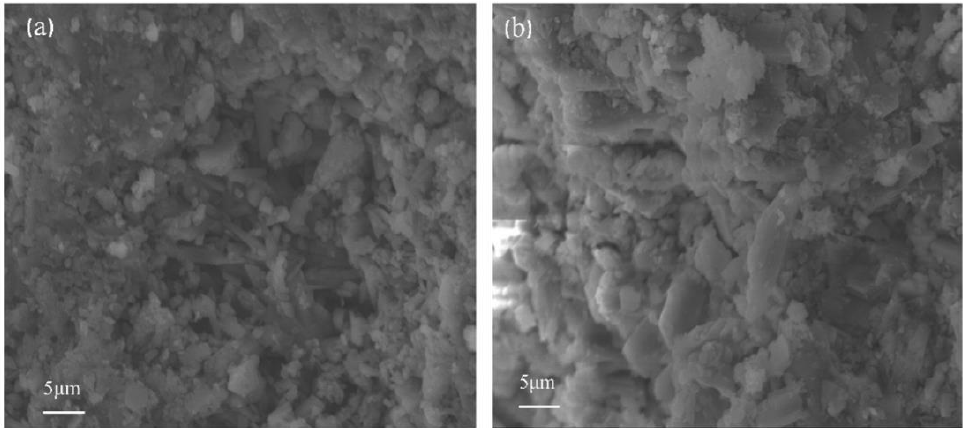
Figure 2. SEM images of gypsum (multiple = 3.5 k, scale = 5.00 μm) ( a ) blank dental gypsum, ( b ) 0.80% aluminum stearate.